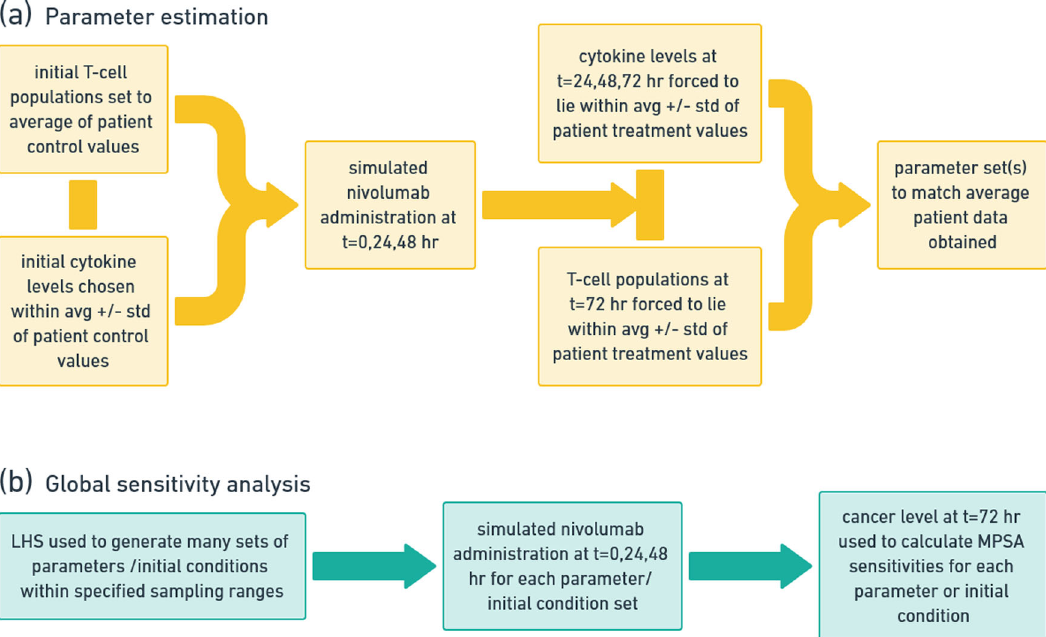
Fig. 6 The computational pipeline used to: a determine nominal parameter sets by matching to the average patient data and b use Latin hypercube sampling (LHS) to perform global sensitivity analysis and simulate a large patient clinical